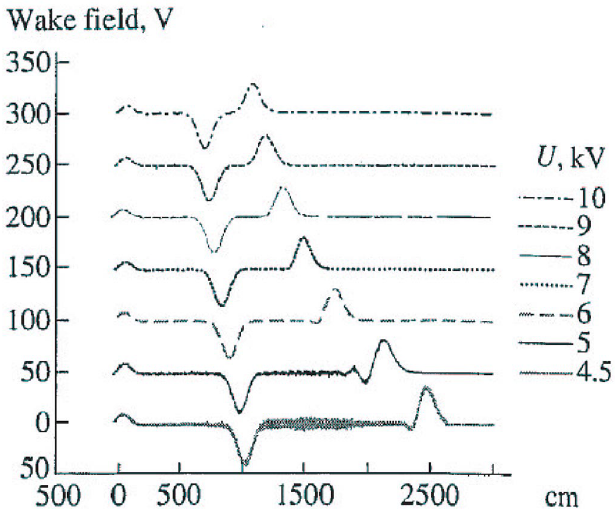
FIG. 83. (Color) Potential of the longitudinal waves in the TEL electron beam after the passage of the proton bunch computed by a flat-disk model; three characteristic features are noticeable: a near zone around 0 cm, caused by polarization and local plasma oscillation, a fast wave (excited when the proton bunch enters into the electron beam), and a slow wave (excited where the proton bunch leaves the electron beam)